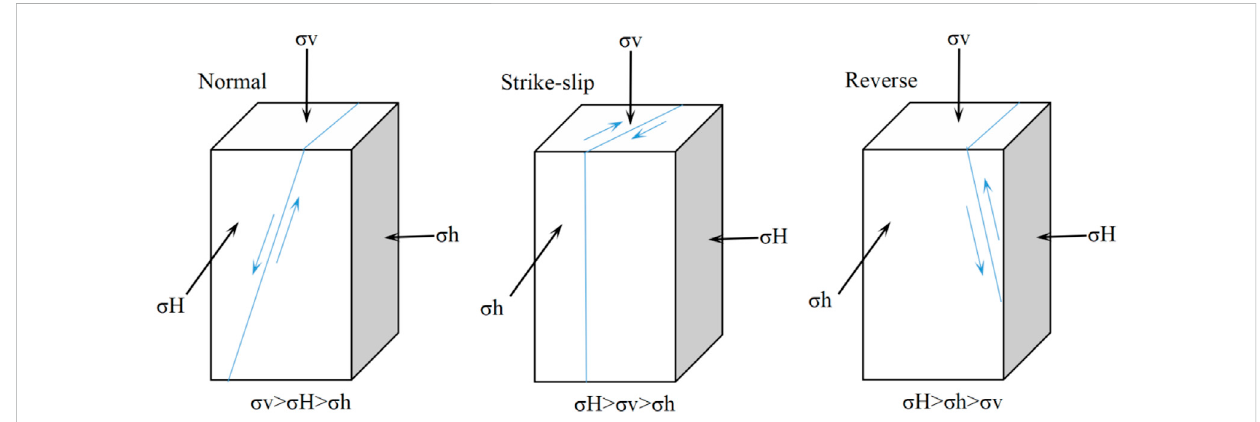
Thedistributionofprincipal in-situ stress( σ v , σ H, and σ h )basedondifferentstressmagnitudeanddirectionsandtheresultingfaulttypes(normalfault, strike-slip fault, and reverse fault